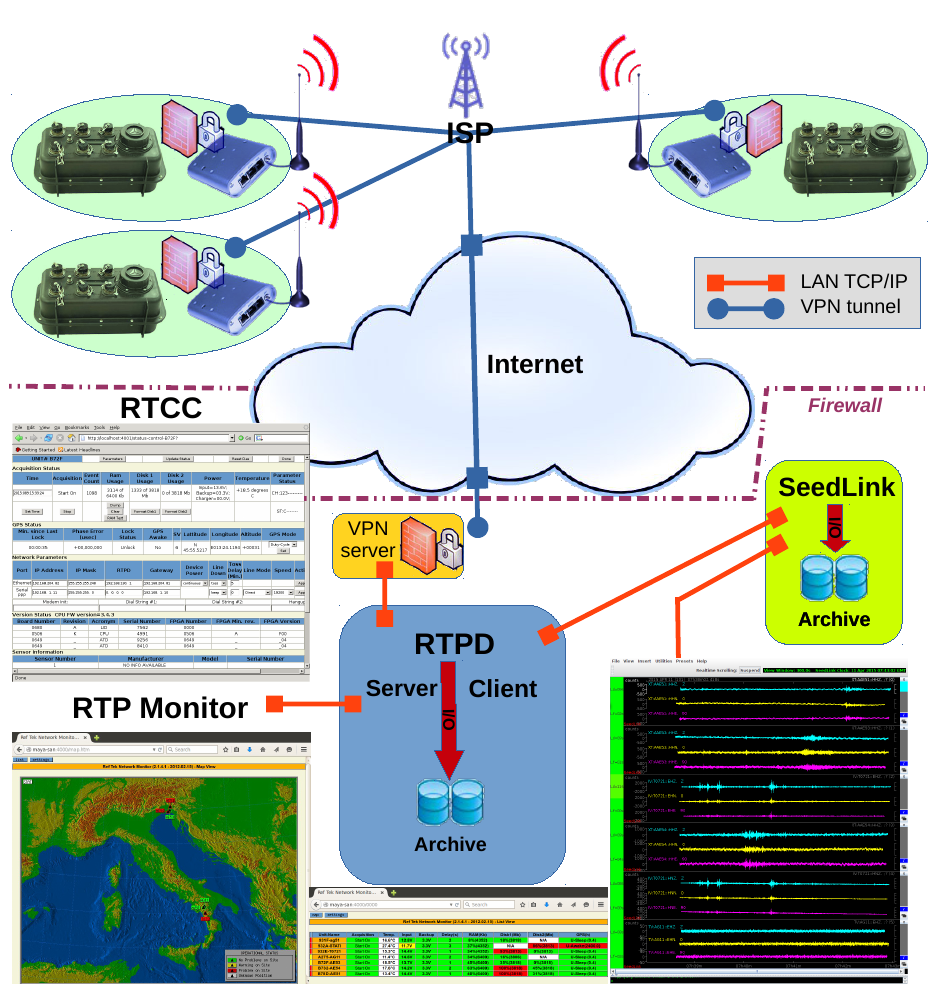
Figure 2. The UMTS OpenVPN based data acquisition scheme adopted for the RefTek data loggers managed by the INGV Mobile Network. When the UMTS router connects to the Internet it establish a VPN tunnel with the OpenVPN server installed on the data acquisition server. From this moment the remote data logger connects to the RTPD data service on a private LAN. All devices and the data acquisition process can be monitored and configured using specific tools. All the data acquired by the RTPD is made available to the SeedLink server. This scheme can be used with any Ethernet capable data logger available on the